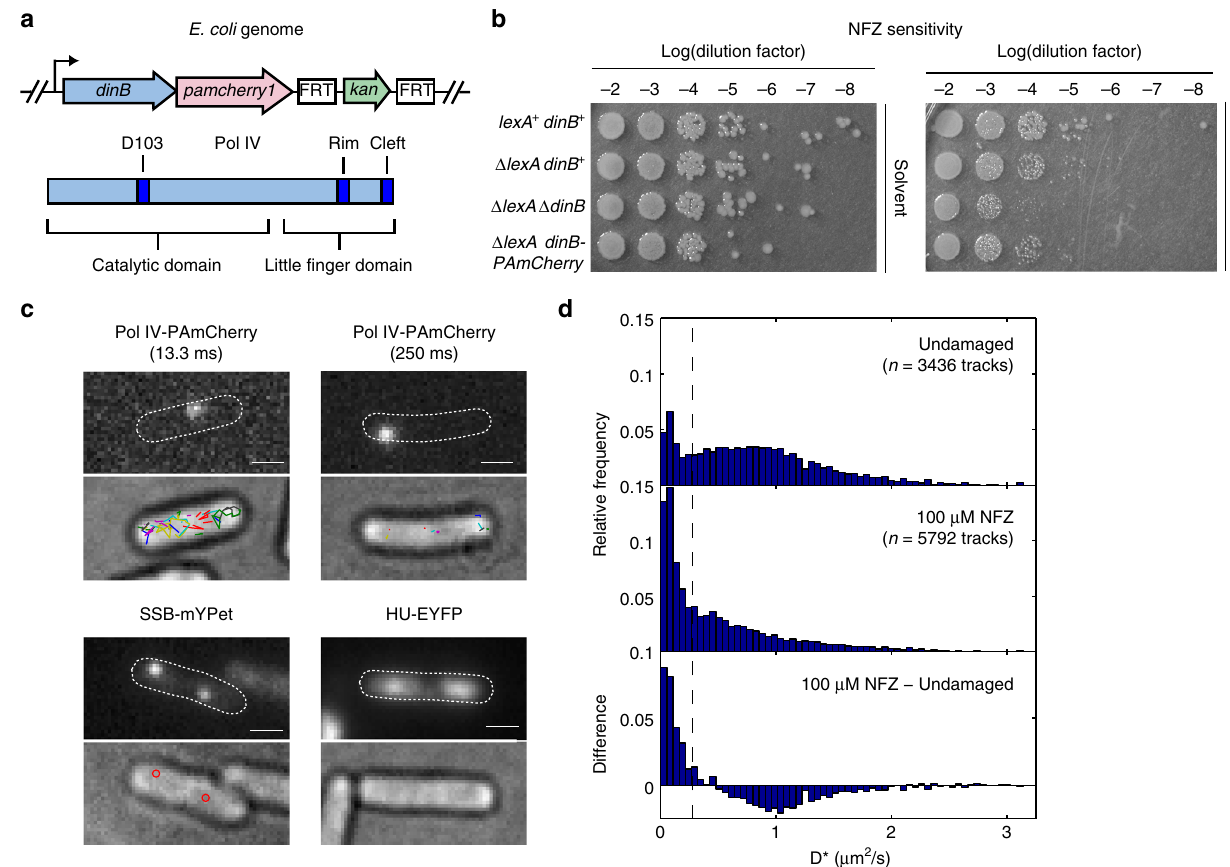
Fig. 1 Particle-tracking PALM imaging of a functional Pol IV-PAmCherry fusion. a Schematic of the fusion of the photoactivatable fl uorescent protein gene pamcherry1 to the C terminus of the dinB gene encoding Pol IV (top) and schematic of the relevant Pol IV domains and residues (bottom). b Serial 10-fold dilutions of E. coli strains grown on LB agar plates without (left) and with (right) nitrofurazone (NFZ) added at 8 µ M concentration. c Top panels: representative fl uorescence micrographs of single activated Pol IV-PAmCherry molecules recorded with 13.3 ms (top left) and 250 ms (top right) integration times, SSB-mYPet foci (bottom left), and a nucleoid labeled with HU-EYFP (bottom right), with overlays of the cell outlines. Bottom panels: the corresponding bright fi eld micrographs with an overlay of all detected Pol IV-PAmCherry tracks (top left and top right) or all detected SSB-mYPet foci (bottom left) in the cell (Scale bars: 1 µ m). d Distributions of the apparent diffusion coef fi cient ( D *) for Pol IV-PAmCherry in undamaged (top) and 100 µ M NFZ-treated cells (middle), and the difference (bottom). The dashed lines indicate the threshold D * value for bound molecules ( D * < 0.275 µ m 2